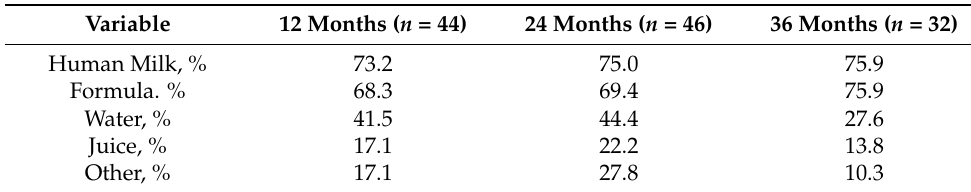
Table 3. Bottle-feeding consumption trends. Reported as percent of children consuming the food within the age group.